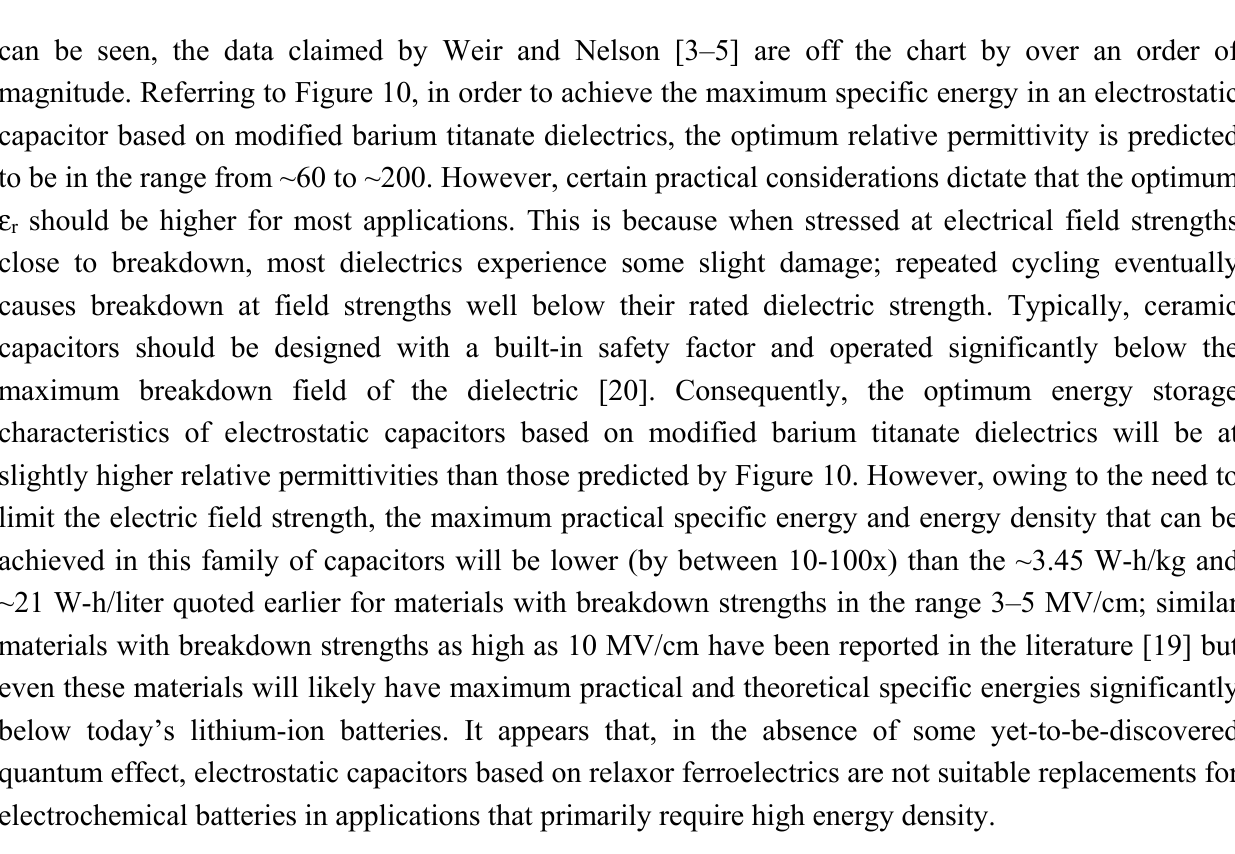
Figure 9. Plot of log energy density vs . log relative permittivity for a family of materials with a set polarization and breakdown